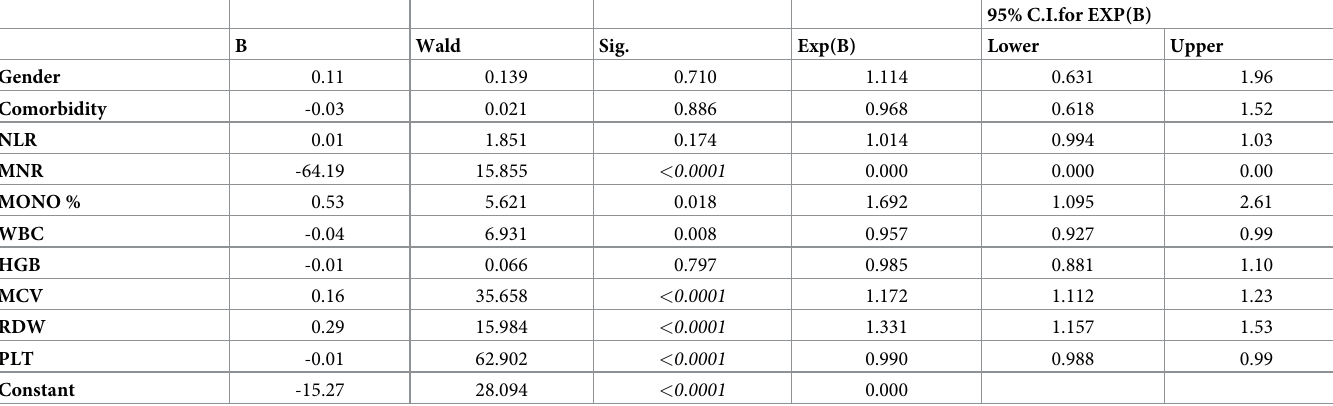
Table 3. Multivariate logistic regression analysis of laboratory and demographic parameters according to mortality.